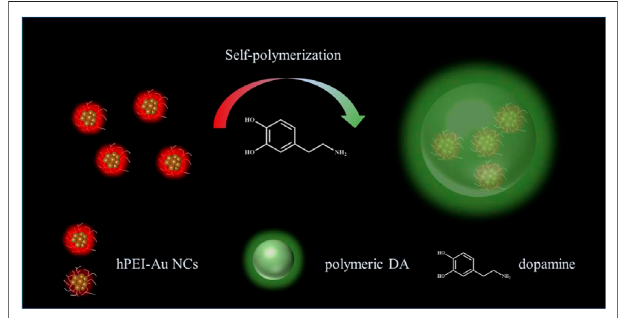
FIGURE 1 | Schematic illustration of ratiometric DA detection with the hPEI-Au NC nanoprobe.